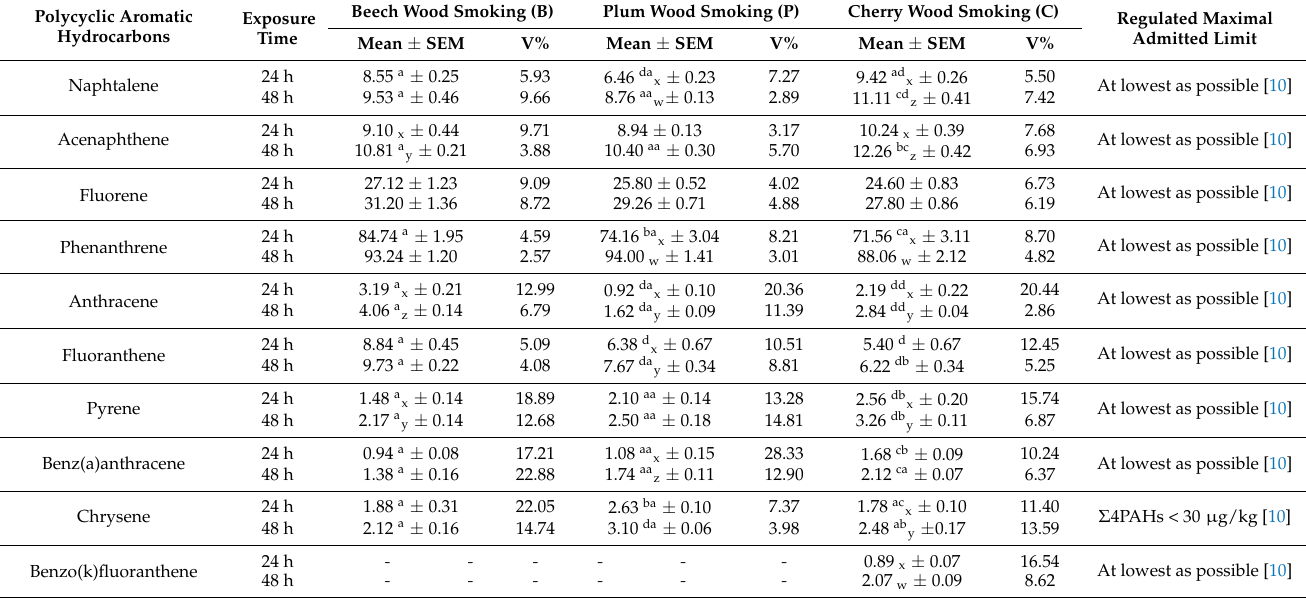
Table 4. Variance of total PAHs accumulation in duck meat ( µ g PAH/kg meat,